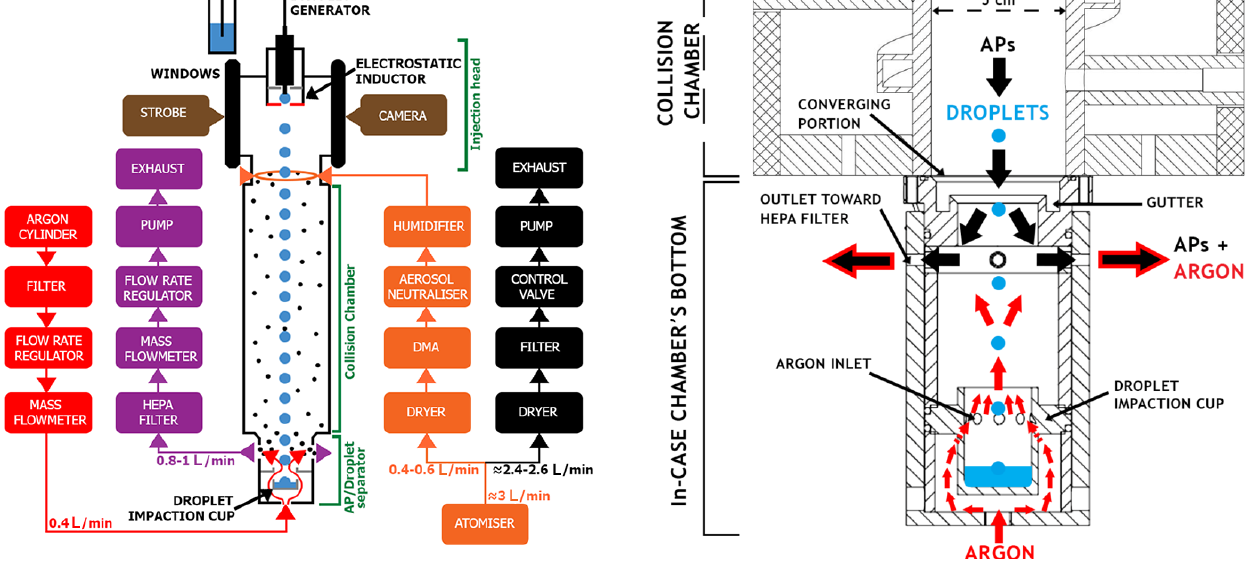
Figure 4. View of the In-CASE chamber’s bottom – AP and droplet